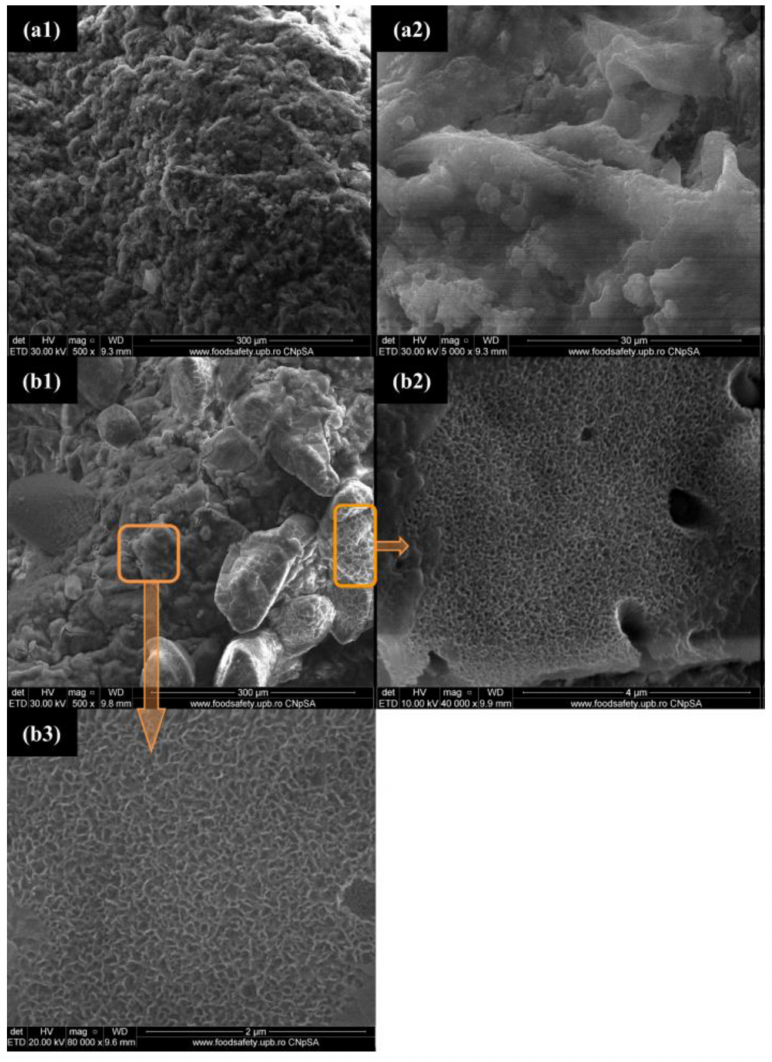
Figure 4. SEM micrographs of CS–FG3 sca ff olds after 7 days ( a1 , a2 ) and 14 days ( b1 – b3 ) of immersion in simulated body fluid